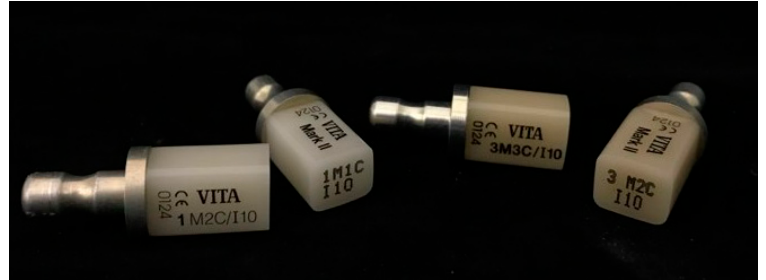
Figure 7. Vitablocs ® mark II 3D-master with the label of manufacturer’s shade on the block. The mean of L, a, and b values obtained by 5 methods including DSLR + TF, DSLR + RF, SMART, IOS, and SPEC were statistically compared to the control group for